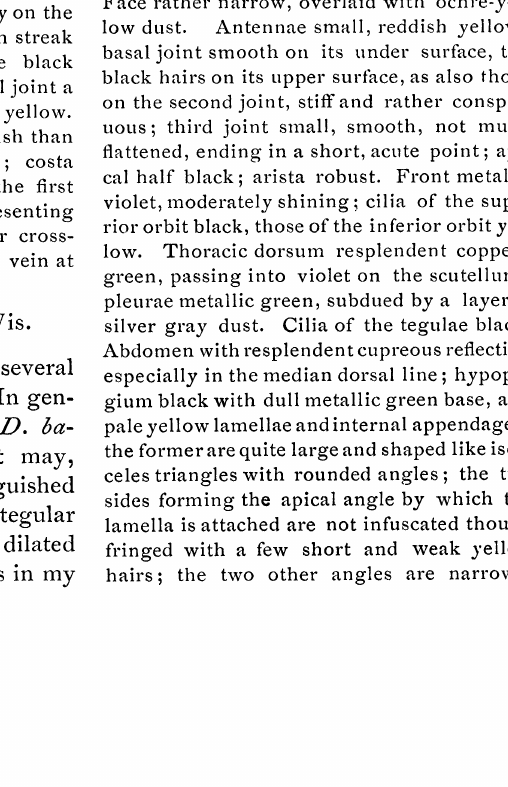
blackeed from the tip of the first joint.